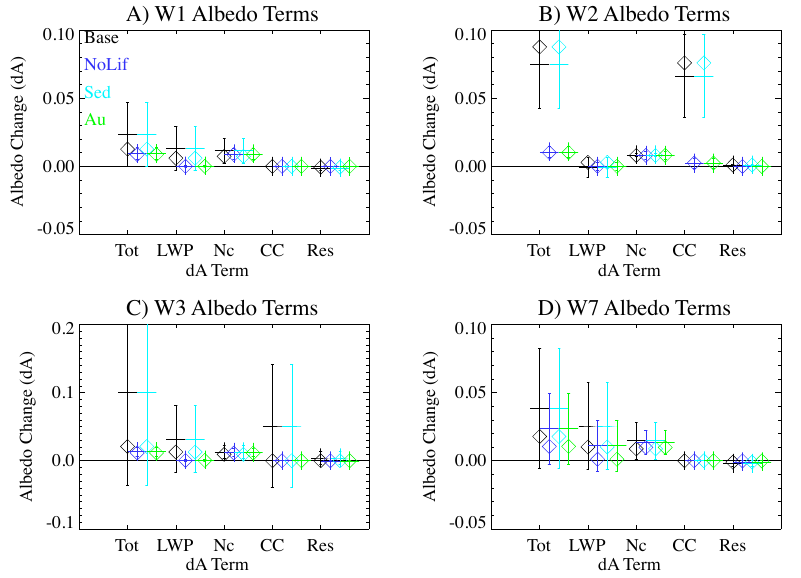
Figure 3. Albedo change by different sensitivity (d A ) terms from different warm rain cases. (a) Warm 1, (b) warm 2, (c) warm 3 and (d) warm 7. Albedo terms in each panel correspond to the total (Tot) change and the portion due to liquid water path (LWP), number concentration ( N c ), cloud coverage (CC) and a residual (Res); the standard case (Base) is in black. Also shown are the no lifetime effects case (dark blue) and the two components of the lifetime effect: sedimentation (cyan) and autoconversion (green).